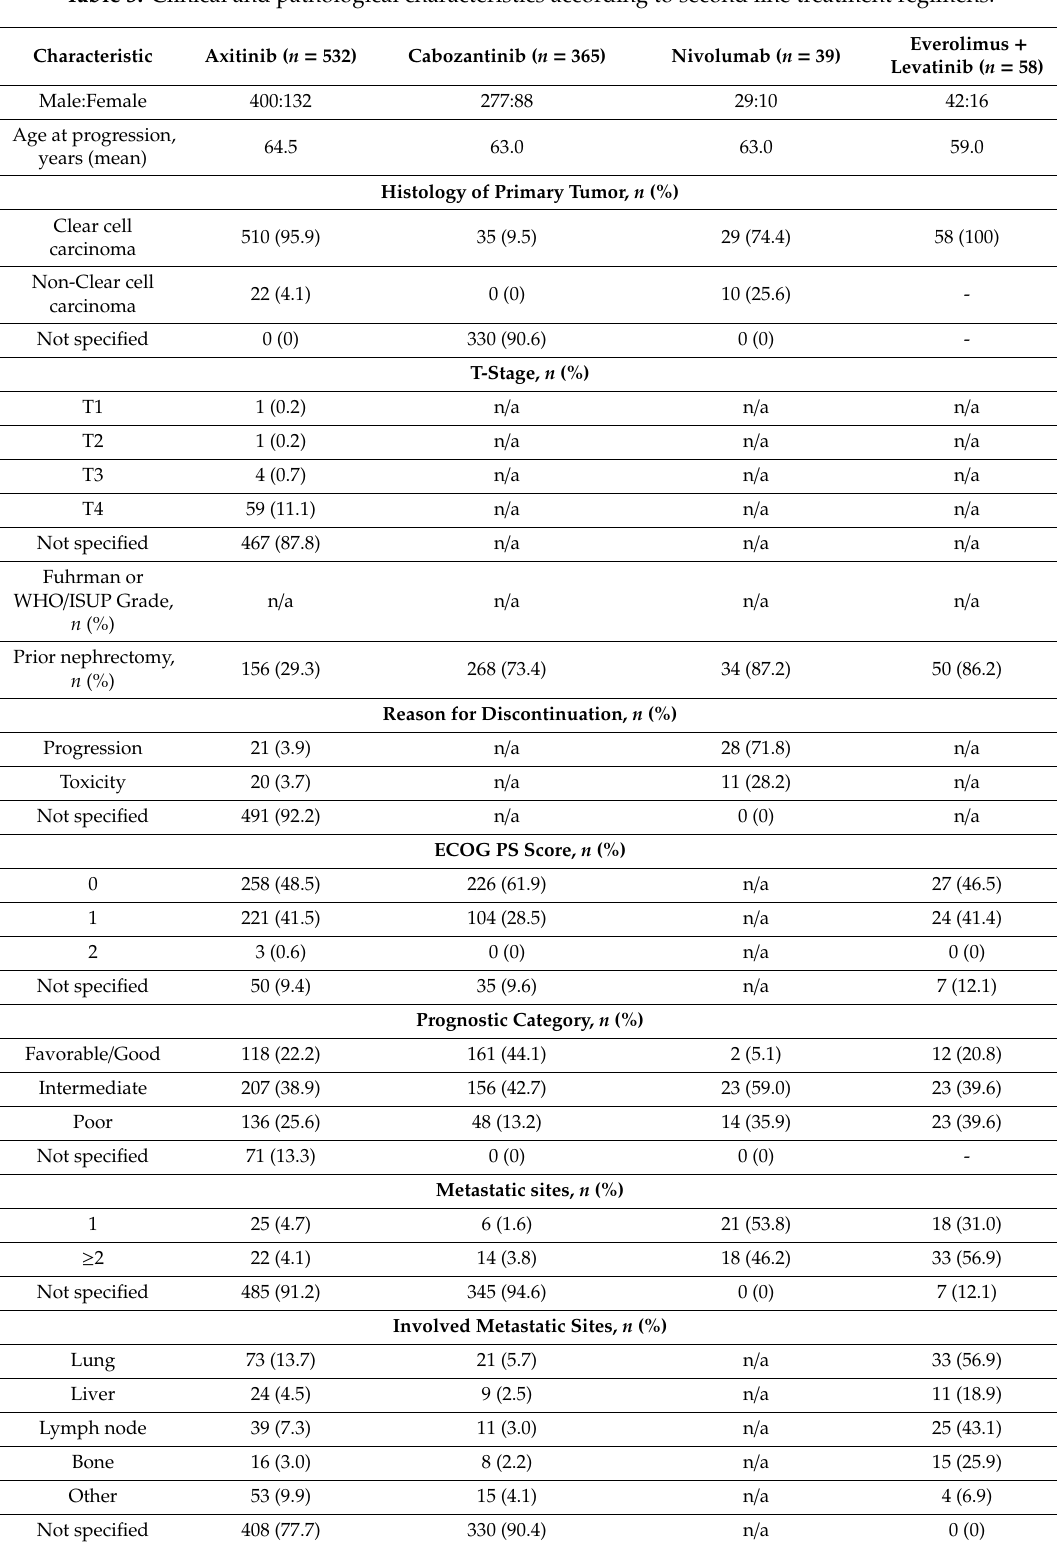
Table 3. Clinical and pathological characteristics according to second line treatment